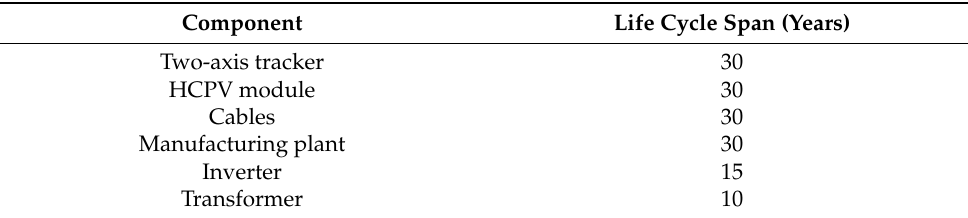
Table 2. Life expectancies of HCPV system components